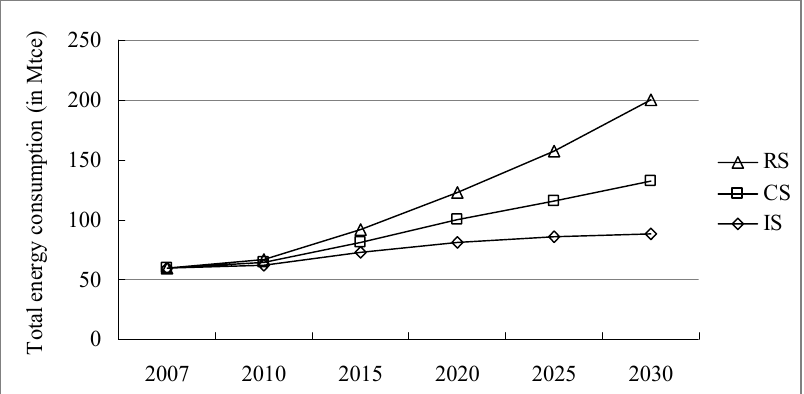
Figure 1. Energy consumption under the three scenarios from 2007 to 2030.